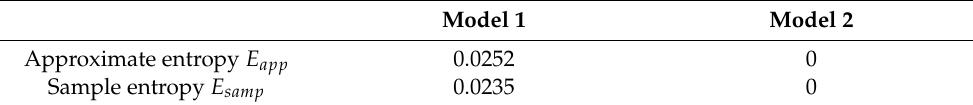
Table 6. Dynamic system criteria for carbon dioxide CO 2